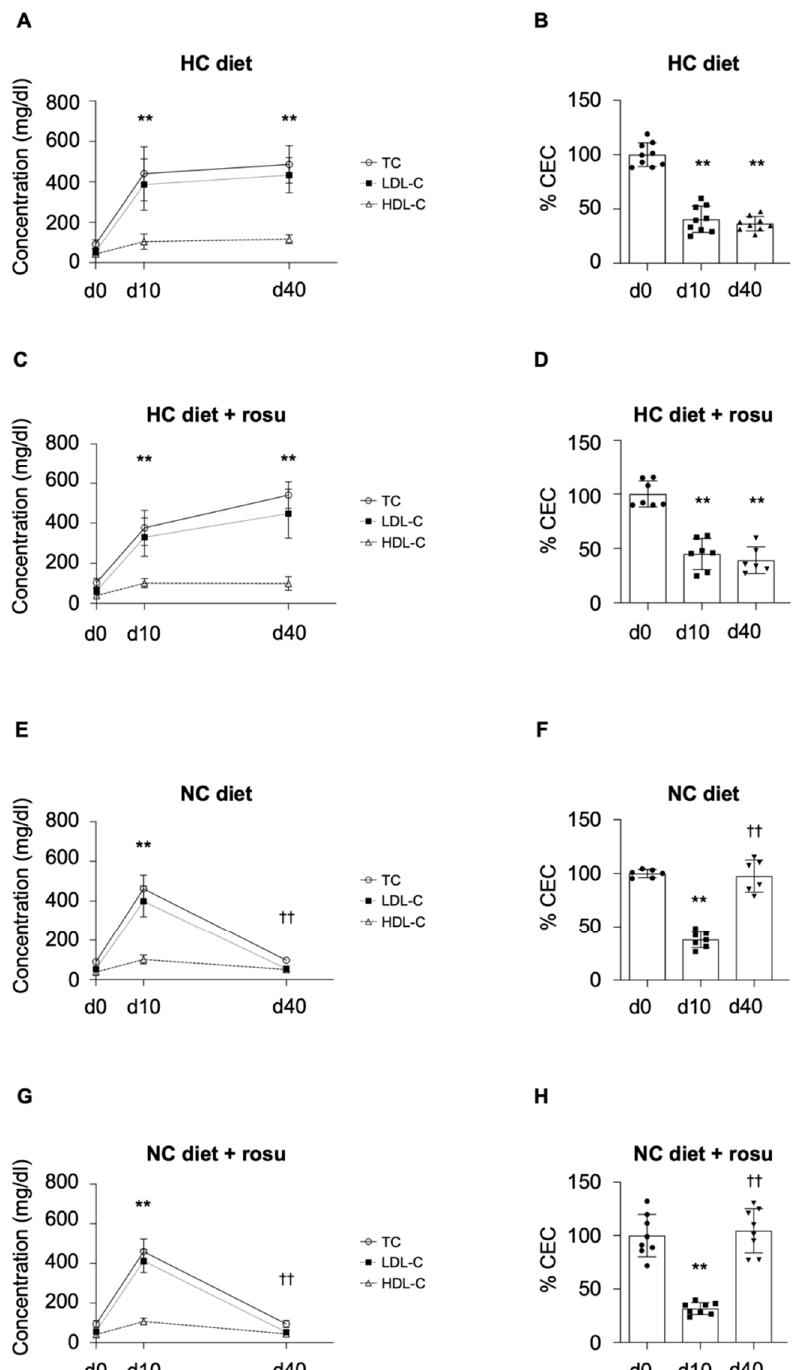
Figure 2. Effects of diet and rosuvastatin intervention on lipid parameters and CEC. Changes in plasma total cholesterol (TC, circle with continuous line), low-density lipoprotein cholesterol (LDL-C, square with dotted line), and high-density lipoprotein cholesterol (HDL-C, triangles with dashed line) levels ( A , C , E , G ), and percent cholesterol efflux from macrophages to HDL (% Efflux; B , D , F , H ) are depicted as mean (bars or line through respective symbol) ± SD (whiskers) for all four groups over the period of 40 days. Shapiro–Wilk test confirmed normality (alpha = 0.05), and data were analyzed by unpaired t-test and considered significant with a p -value < 0.05. ** p < 0.0001 in comparison to day 0; †† p < 0.0001 in comparison to day 10. CEC: cholesterol efflux capacity; TC: total cholesterol; HDL: high-density lipoprotein cholesterol; LDL: low-density lipoprotein cholesterol; HC: hypercholesterolemic; NC: normocholesterolemic; rosu: rosuvastatin; d0–40: day 0–40.